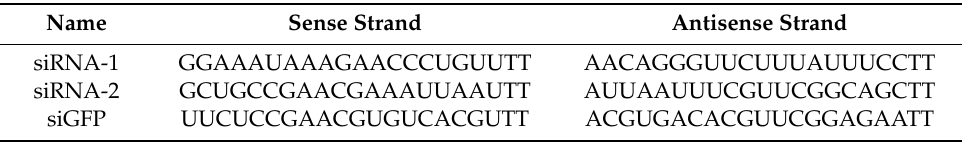
Table 2. Sequences of siRNA against Bmserpin2